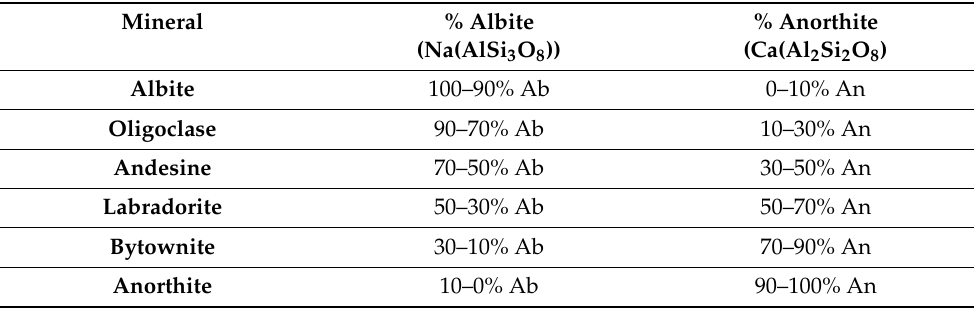
Table 3. Variation in minerals within the Plagioclase Feldspar group of materials as shown in Figure 6